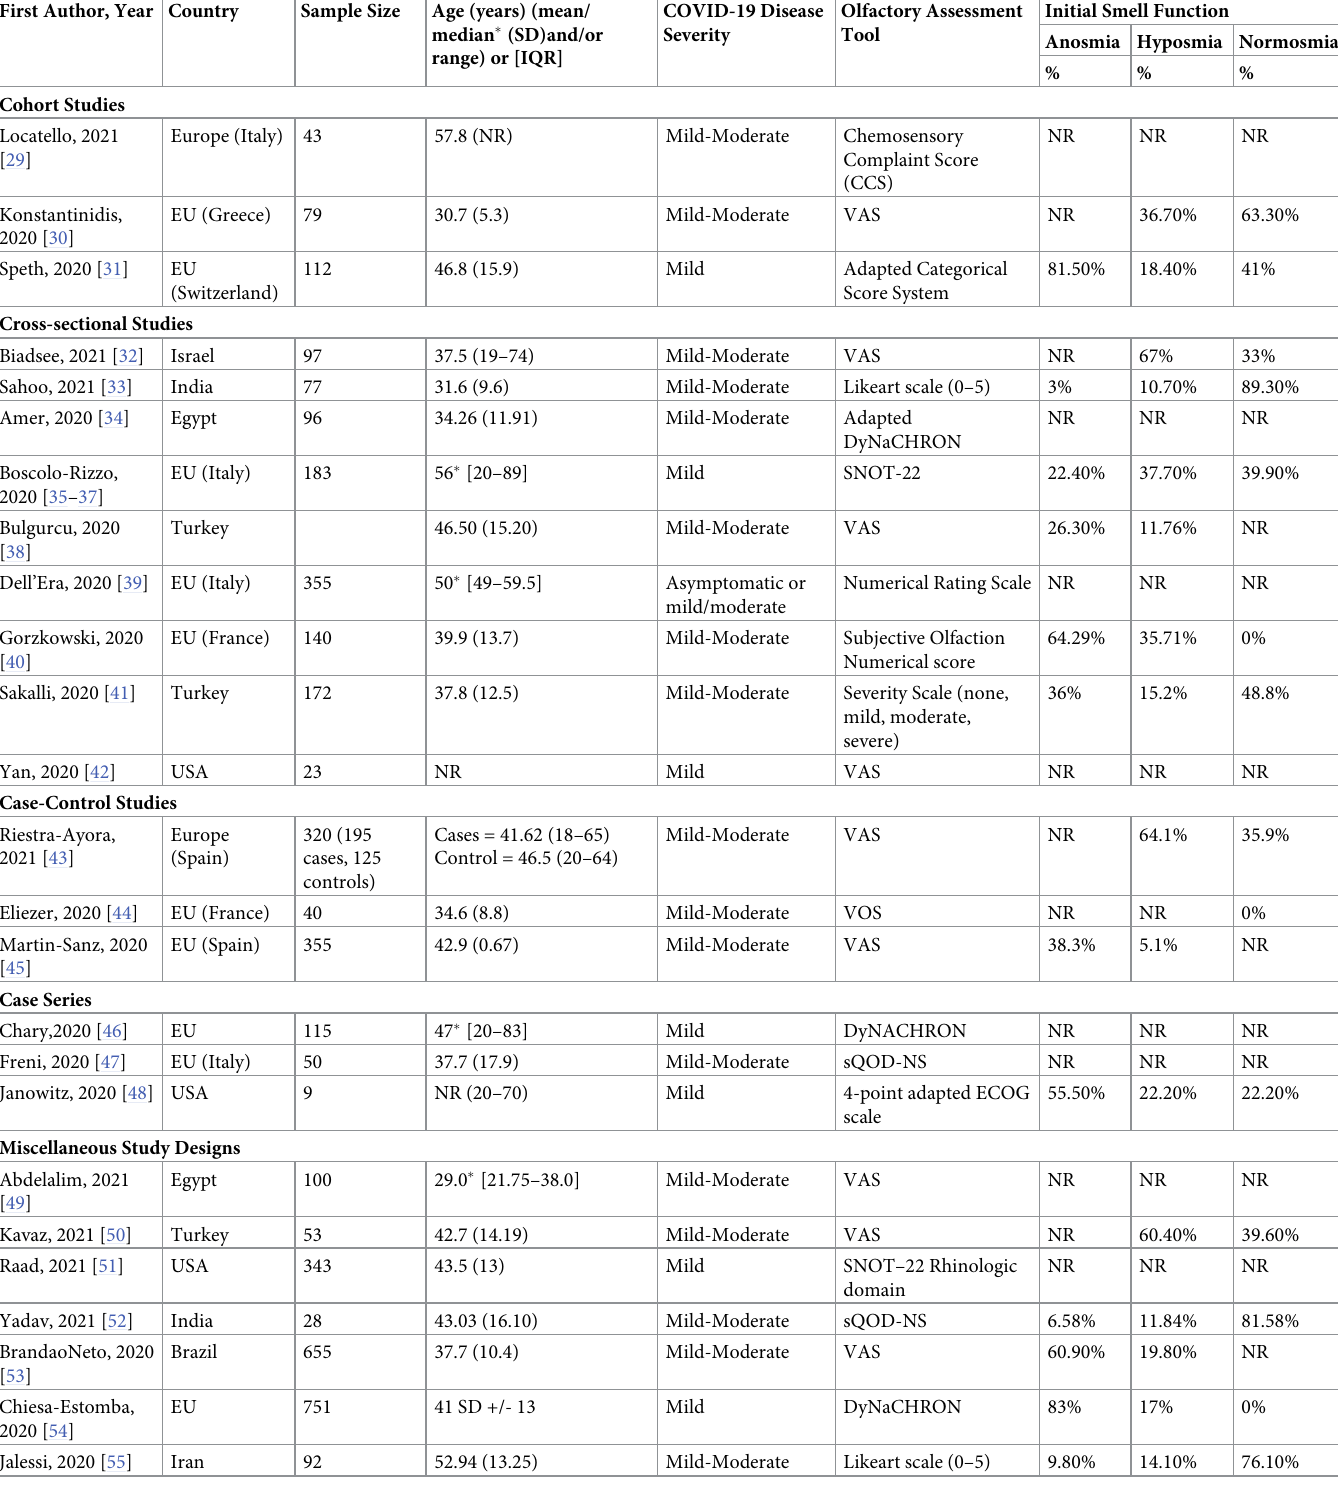
Table 2. Characteristics of studies that used subjective olfactory